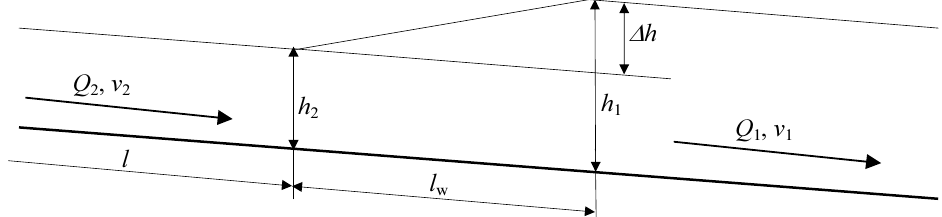
Fig. 6. Scheme of a reflux